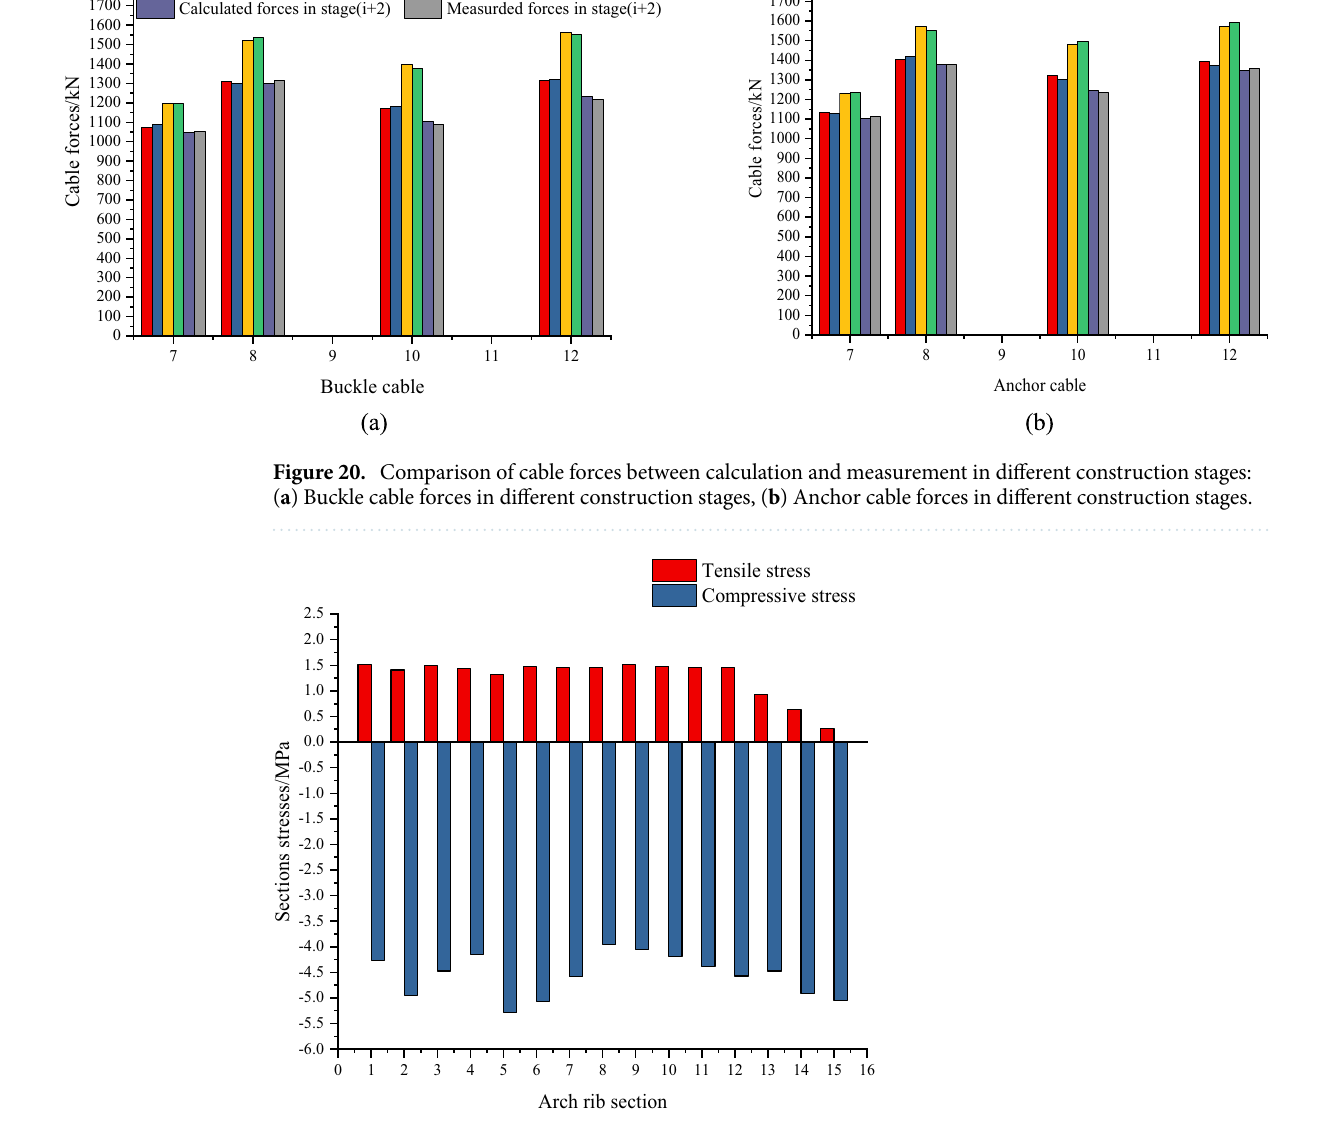
Figure 21. Stress ranges of the top edge of arch rib key